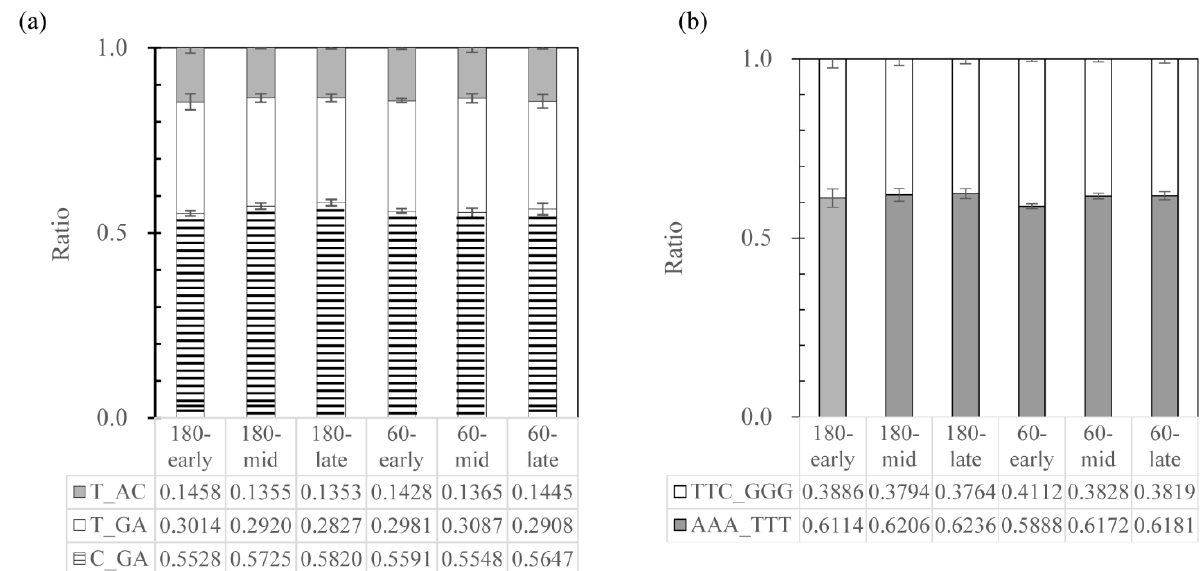
Figure 1. 16S rRNA types of strain w15 ( a ) ratio of T_AC (grey)/T_GA (blank)/C_GA (zebra lines) at V2 region, and ( b ) ratio of TTC_GGG (blank)/AAA_TTT (grey) at V3 region. 180: samples from 180 rpm shake cultures; 60: samples from 60 rpm cultures; early: 24 h; mid: 5 days; late: 13 days.